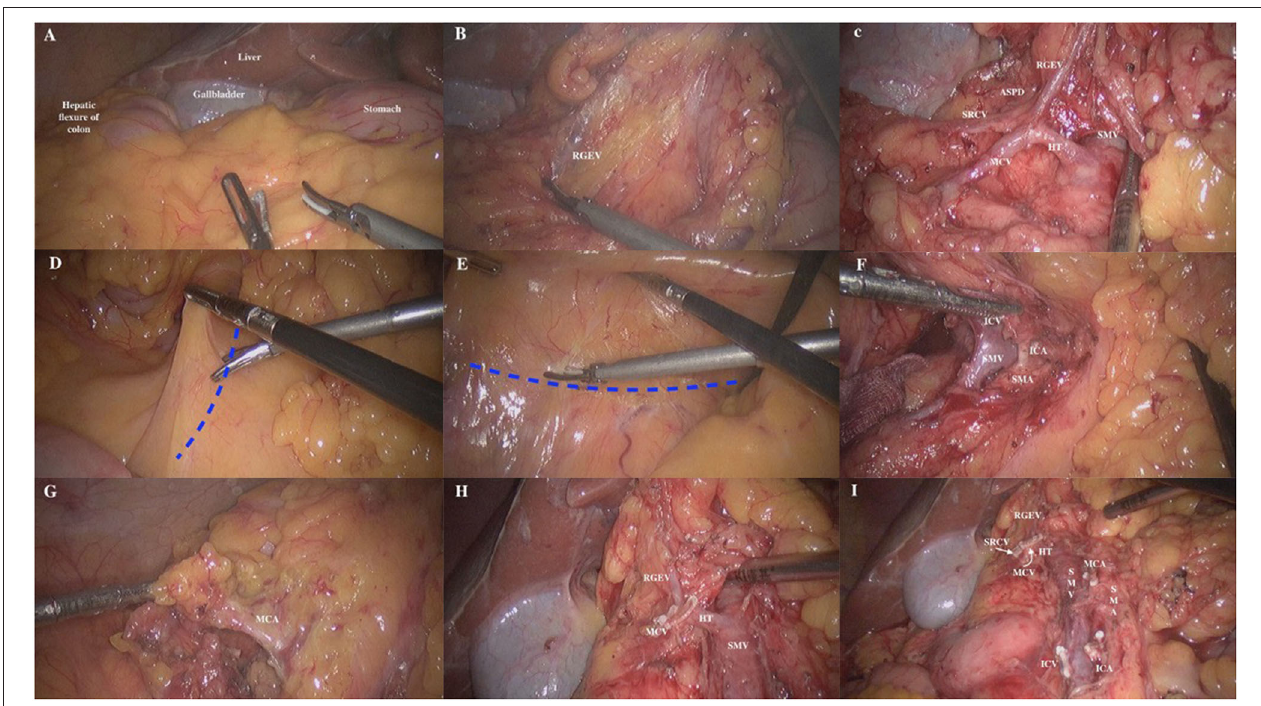
FIGURE 2 | The steps of priority management of the Henle trunk in cranial-to-caudal approach. (A) The gastric-colon ligament was incised along the lateral edge of gastroepiploic vessel arch. (B) The RGEV was exposed and dissected at anterior lobe of the transverse mesocolon. RGEV right gastroepiploic vein. (C) Along the RGEV, the SRCV was dissected and exposed. (D) The projection of SMV served as the trajectory of incision and was marked. (E) The endoscope entered the fusion fascia space from the lower portion of the horizontal part of the duodenum. (F) The SMV was exposed to the right side of SMA, and then the SMA, SMV, and their branches were dissected. (G) The branches of SMA were dissected upward along the left side of this vessel. The MCA was ligated and incised. MCA middle colon artery. (H) The MCV was ligated and incised. (I) The regional lymph node dissection was